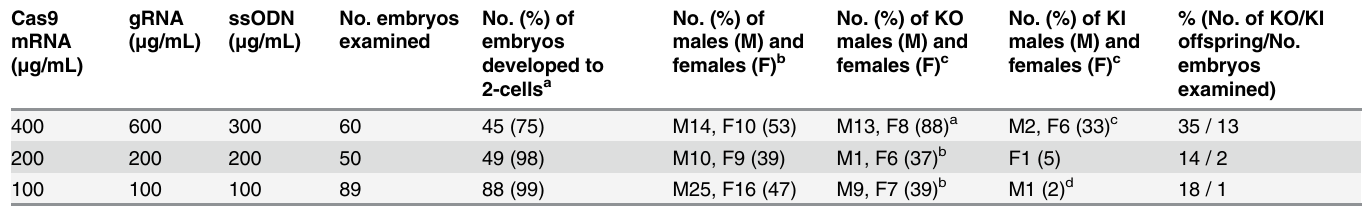
Table 2. Development of rat embryos with introduced RNA and ssODN using the TAKE